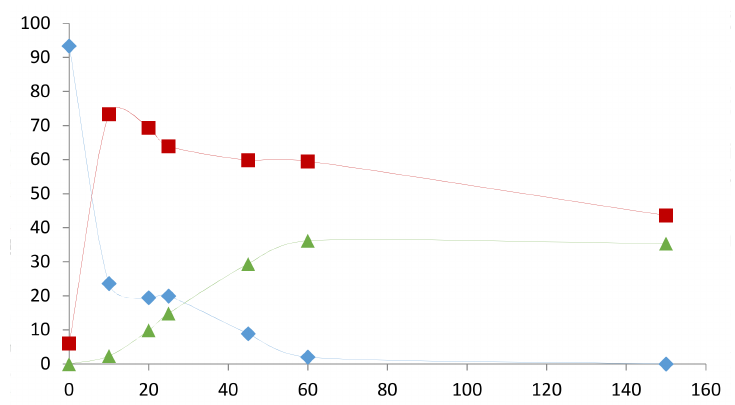
Figure A12. Composition profiles as a function of time with RhH(biphephos)(CO) 2 isolated species without ligand addition in toluene at [ 1 ] 0 /[Rh] = 3000 ( (cid:7) 1 , (cid:4) 1- int -x , (cid:78) 2 + 3 ) (conditions : 1 / 1- int -x (93.5:6.5) = 3.15 mmol, [ 1 ] 0 = 0.4 M, [ 1 ] 0 /[Rh] = 3000, P = 20 bar (CO/H 2 = 1:1), toluene (8 mL), T = 120 ◦